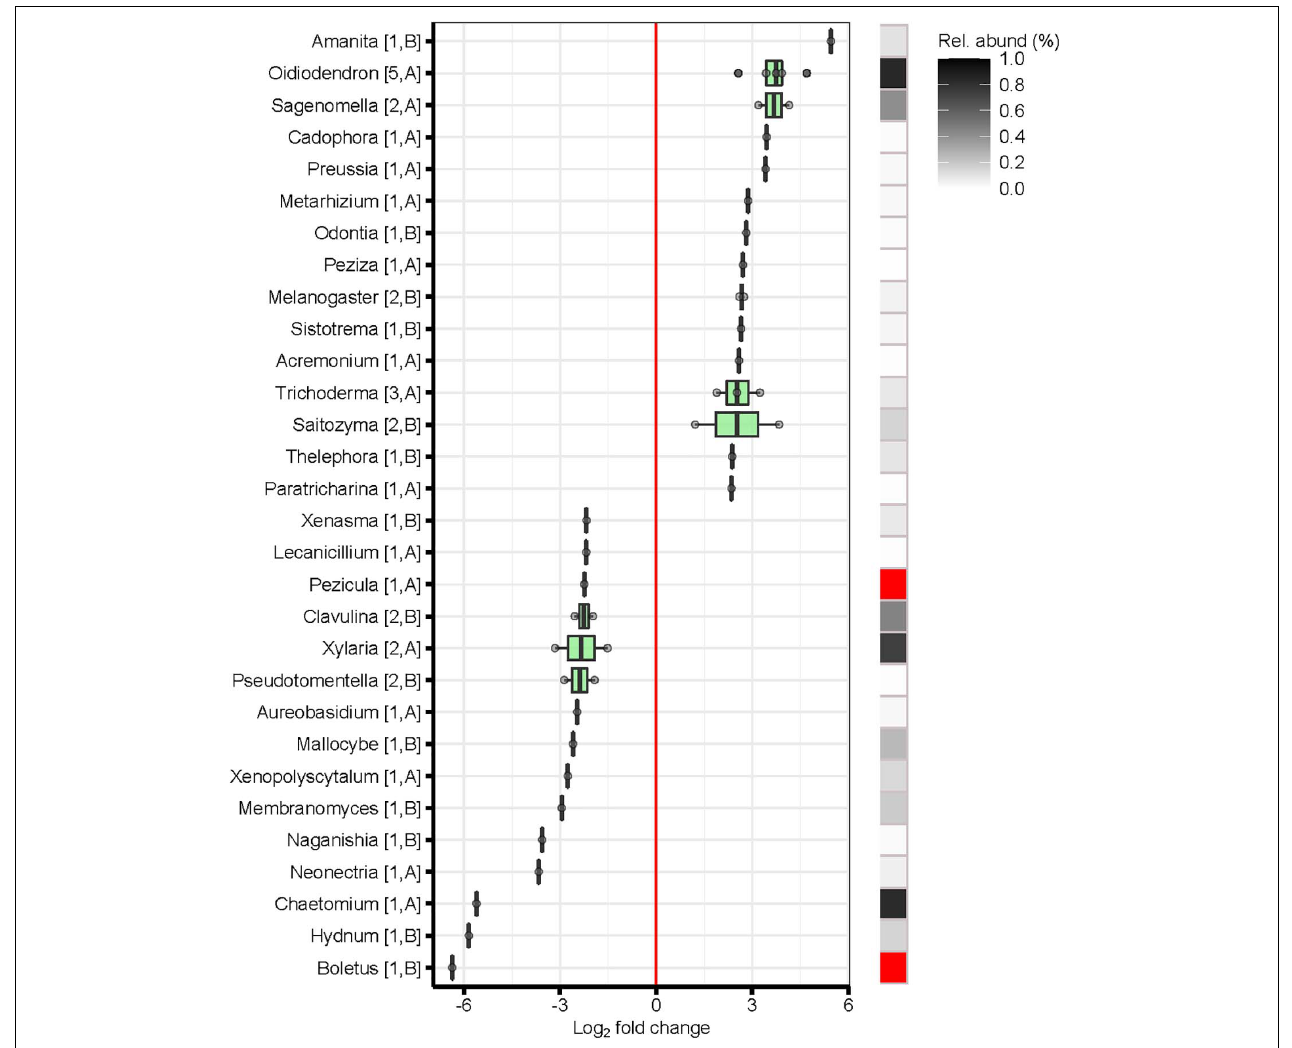
FIGURE 6 | Differentially abundant fungal genera of topsoil (soil layers L1 and L2) vs. subsoil (soil layers L5 and L6). Shown are only significant log 2 -fold changes (LFC) of genera based on a significance level of p < 0.01 after false discovery rate correction. Error bars represent standard deviation. Positive LFC values indicate a higher occurrence of the taxa in the topsoil, whereas negative LFC indicate a higher occurrence in the subsoil. Only thirty genera with the highest (positive) and lowest (negative) mean LFC values were represented. The number of differentially abundant OTUs comprised in each genus, and the phyla to which they belong are indicated in brackets. Relative abundance (%): sum of the abundance of the differentially abundant OTUs belonging to the same genera as a percentage of the total number of sequences across the compared soils. Relative abundance depicted in red exceeds the abundance scale. A, Ascomycota; B, Basidiomycota. Soil layers: L1: 0–10 cm, L2: 15–25 cm, L5: 110–125 cm, L6: 140–155